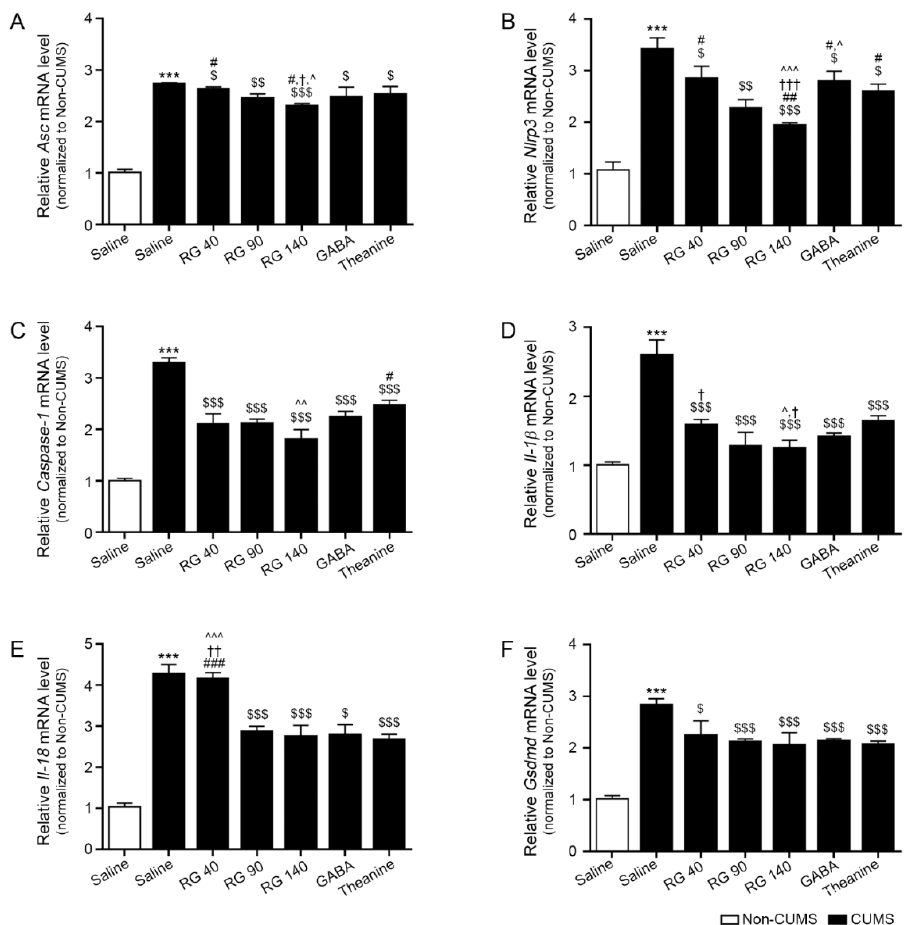
Figure 3. Reduction effects of RG on inflammasome and pyroptosis cytokines in the hypothalamus of CUMS mice model. ( A – F ) The mRNA levels of ASC ( A ), NLRP3 ( B ), Caspase-1 ( C ), IL- 1β ( D ), IL-18 ( E ), and cell death mediated by GSDMD ( F ) were significantly upregulated in CUMS compared to those in the control but downregulated after RG, GABA, and theanine treatment. Data were normalized to Actb, and expression levels were reported relative to the control group using the comparative CT method. Data are presented as the mean ± SD ( n = 3/group). ASC, apoptosis- associated speck-like protein containing a caspase recruitment domain; IL, interleukin; CUMS, chronic unpredictable mild stress; GABA, gamma-aminobutyric acid; GSDMD, gasdermin D; RG, rice germ with 30% GABA; NLRP3, NOD-like receptor family pyrin domain containing 3. ***, p < 0.05 vs. Non- CUMS; $, p < 0.05, $$, p < 0.01 and, $$$, p < 0.001 vs. CUMS; #, p < 0.05, ##, p < 0.01 and ###, p < 0.001 vs. CUMS/RG90; †, p < 0.05, ††, p < 0.01 and †††, p < 0.001 vs. CUMS/GABA; ˆ, p < 0.05, ˆˆ, p < 0.01 and ˆˆˆ, p <0.001 vs.